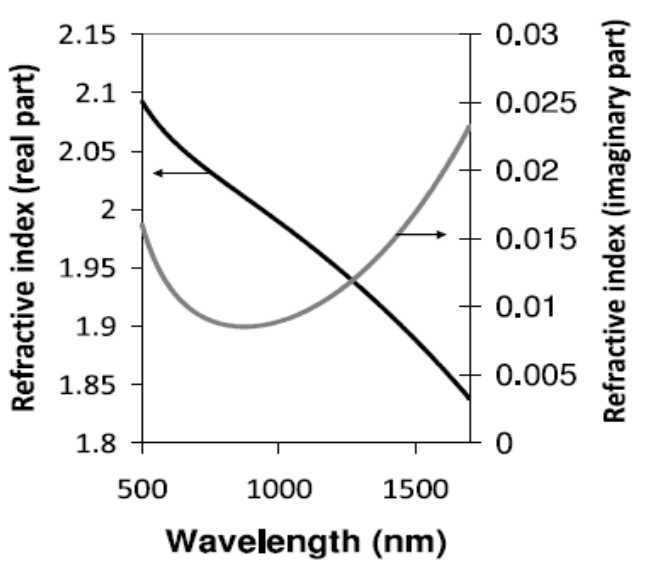
Figure 9. The variation of real and imaginary parts of RI of In 2 O 3 , with wavelength. Reproduced with permission from [136], copyright IOP Publishing.